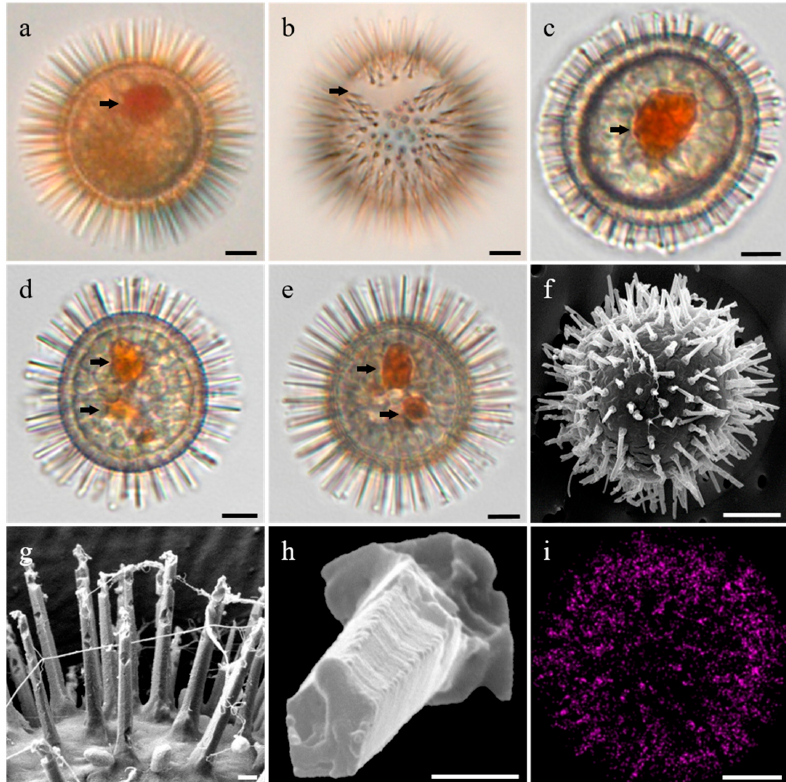
Figure 1. Resting cysts of Scrippsiella precaria from the sediment and cultures: ( a ) resting cyst from the sediment showing a red pigment body (arrow), ( b ) empty cyst showing the archeopyle (arrow), ( c – e ) resting cyst from the culture showing one or two red pigment bodies, ( f ) scanning electron microscopy (SEM) micrograph of a resting cyst, ( g , h ) details of calcareous spines, and ( i ) energy dispersive spectroscopy (EDS) result showing the detection of calcium carbonate (CaCo 3 ) on the surface of a resting cyst. Scale bars: 5 µ m. J. Mar. Sci. Eng. 2021 , 9 , x FOR PEER REVIEW